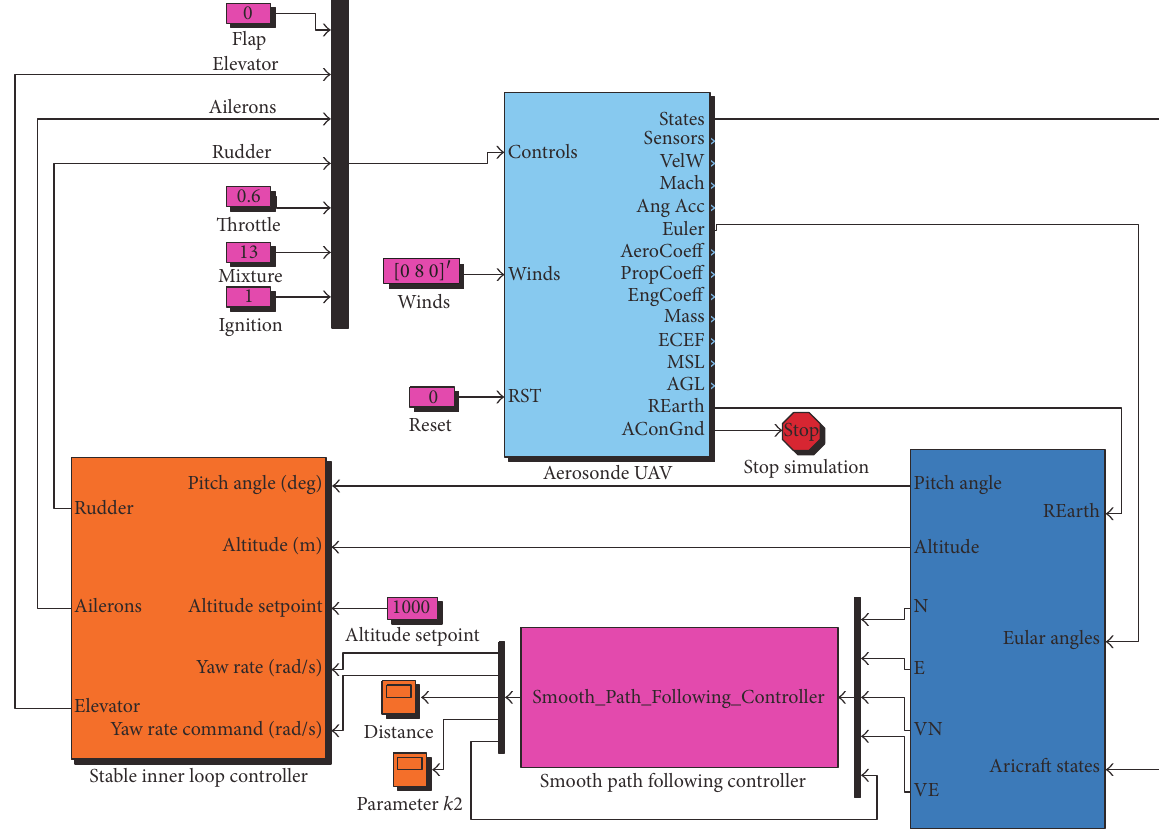
Figure 6: The Simulink block diagram for the simulation